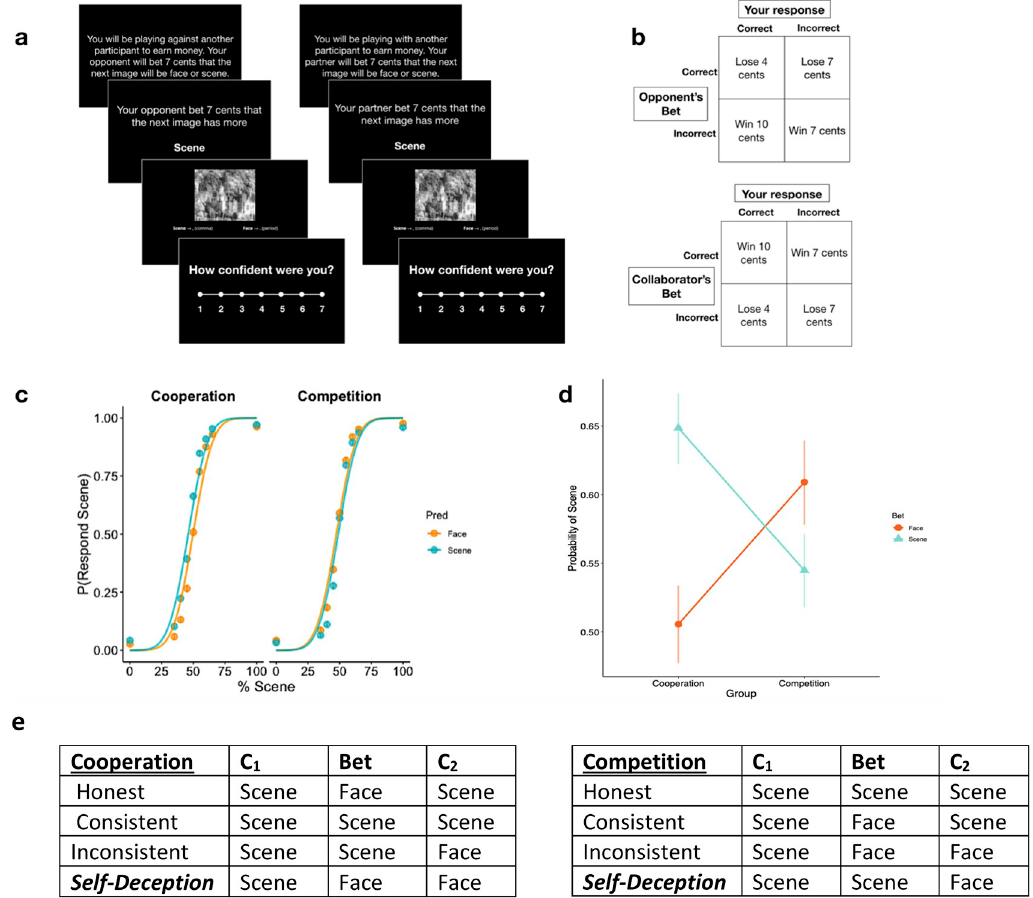
Fig 1. Task structure for C2 phase and interaction effect. A , sequence of task for the 2 conditions. B , payoff matrices for both conditions. Participants should ideally classify the image objectively (as they did in the initial classification phase) without using the bet to inform their decision. C , psychometric functions showing the percentage of scene in the image versus probability of responding scene averaged over all participants. D , participant’s choices displayed a motivational bias. The bet x group interaction shows that participants in the cooperation group tended to align with the bet (higher probability of answering scene when the bet was scene), while the competition group tended to disagree with the bet (higher probability of responding with scene when the bet was face). E , response patterns for the two experimental conditions. Self-deception is defined differently based upon experimental